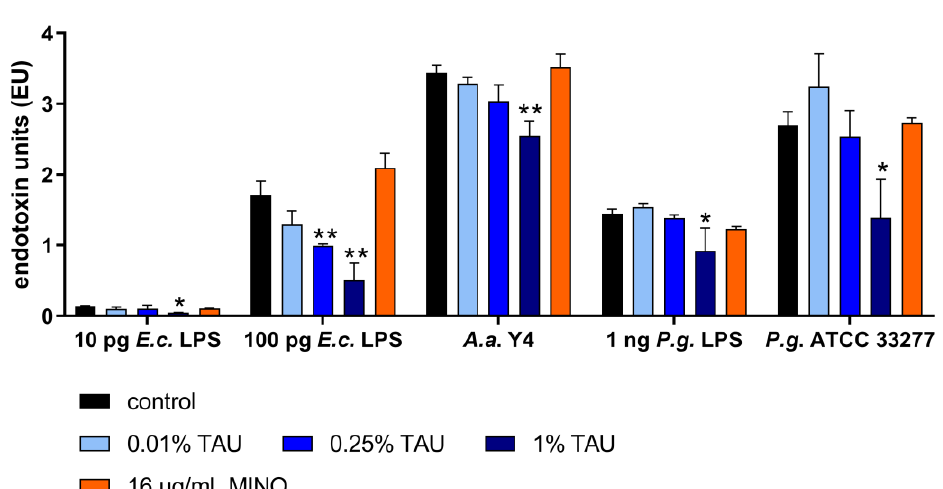
Figure 2. Endotoxin activity (endotoxin units (EU), mean ± SD) measured by Limulus amebocyte lysate assay of Escherichia coli (E.c.) LPS, Porphyromonas gingivalis (P.g.) LPS as well as P. gingivalis ATCC 33,277 and Aggregatibacter actinomycetemcomitans Y4, without and with 2 h pre-exposure to 0.01%, 0.25%, 1% taurolidine (TAU) and 16 µg/mL minocycline (MINO).* p < 0.05, ** p < 0.01 vs. respective control.